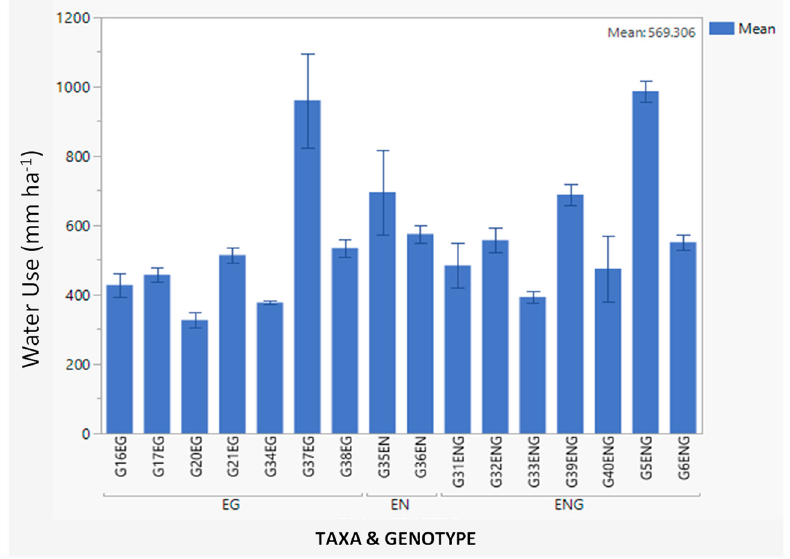
Figure 3. Average annual water use (mm ha − 1 ) for each selected genotype, evaluated across all sites from 2017 to 2018.